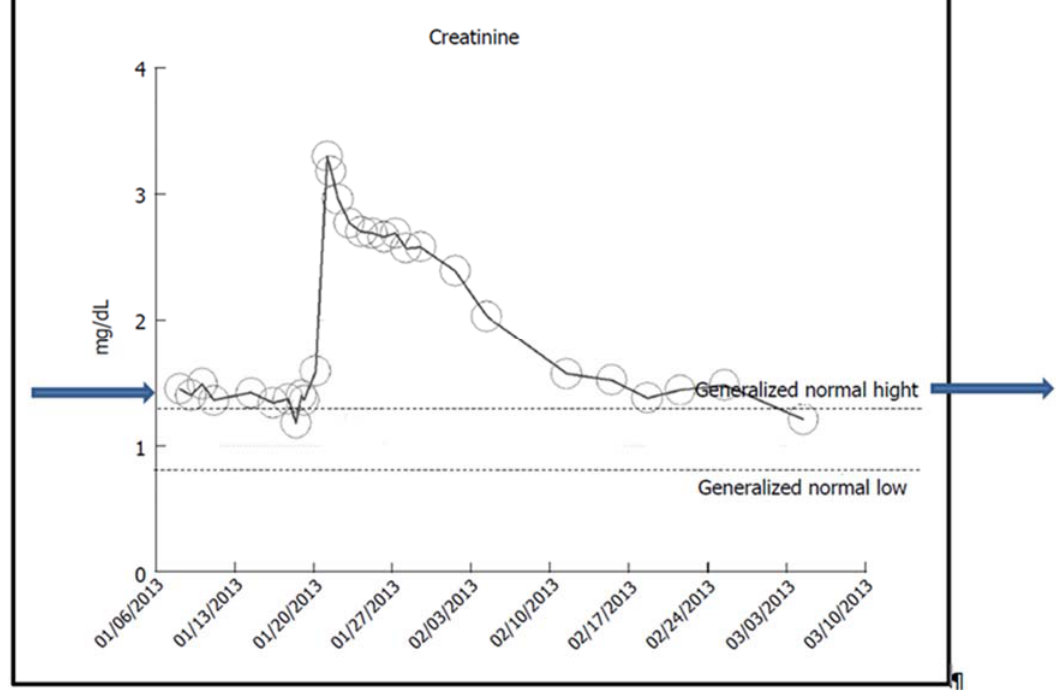
Figure 1. Serum creatinine trajectory in an obese hypertensive with glucose intolerance showing rapid and full recovery of renal function following AKI on CKD from MRSA